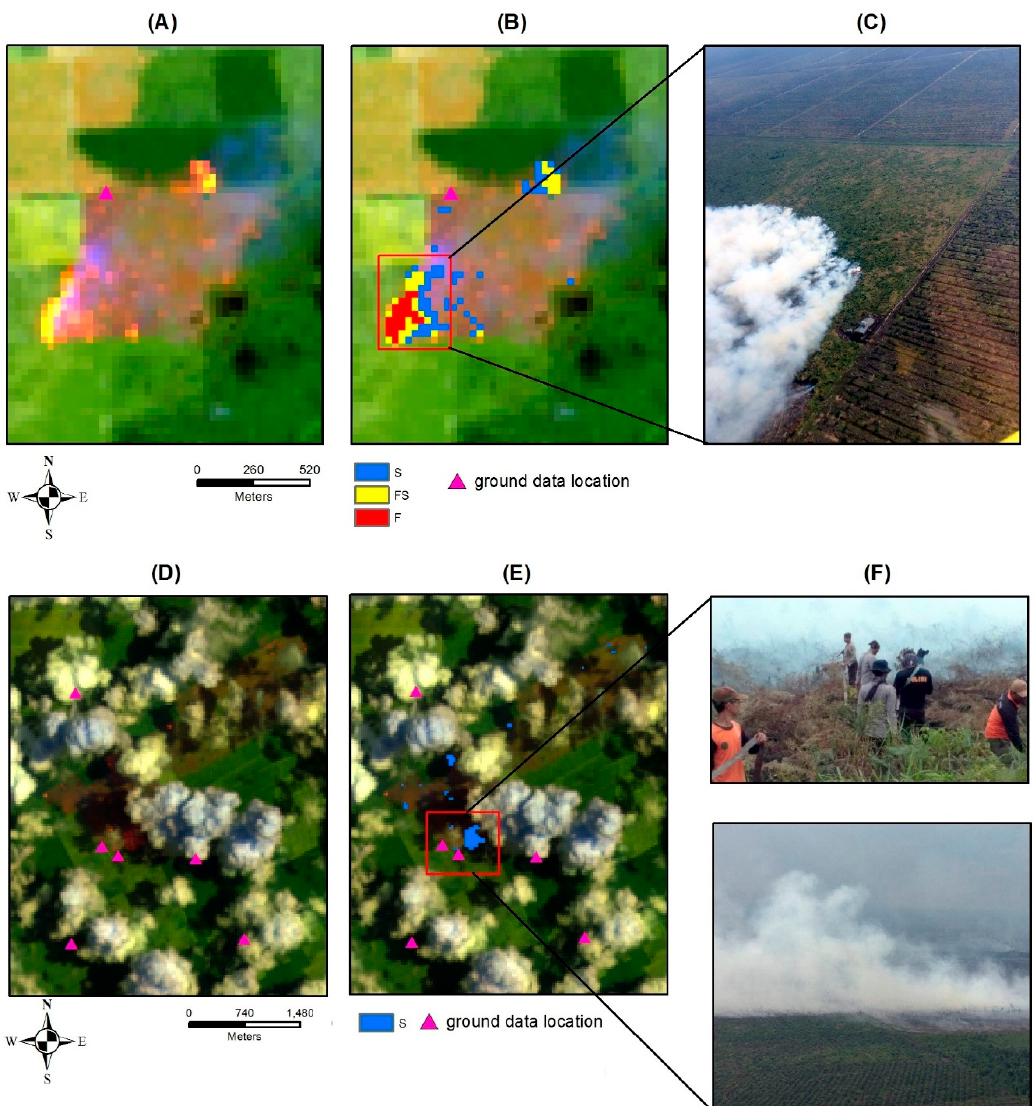
Figure 12. ( A , B ) The 764 RGB image of Landsat-8 on 20 August 2016 showing a combustion area with the result of peatland combustion mapping and (C) a helicopter oblique picture taken on the same day taken in Riau Province; ( D , E ) The 764 RGB Image of Landsat-8 on 4 April 2018 and the result of peatland combustion mapping with ground truth location marked in red square. The pictures ( F ) of peatland fires from the ground and helicopter; sourced from local BNPB of Riau Province on 4 April 2018.